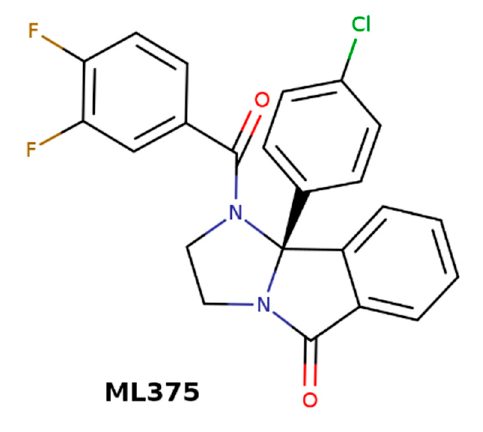
Figure 9. Structure of M 5 -selective negative allosteric modulators (NAM) of acetylcholine ML375.